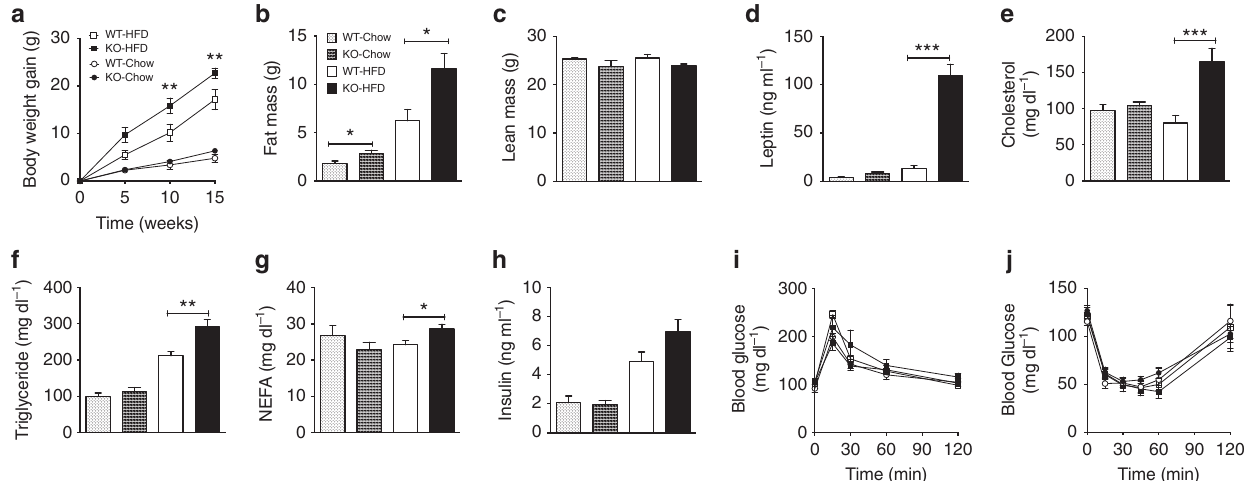
Figure 2 | HDAC5 knock-out mice are prone to diet-induced obesity. Male HDAC5 WT and KO littermates were subjected to either chow or HFD and evaluated for ( a ) body weight gain over a total of 15 weeks; ( b ) fat and ( c ) lean mass after 8 weeks of chow or HFD exposure ( n ¼ 6–8). After 10 weeks of HFD and 15 weeks of chow exposure, plasma ( d ) leptin, ( e ) cholesterol, ( f ) triglyceride, ( g ) non-esterified fatty acid and ( h ) insulin levels were measured in additional cohorts of chow- or HFD-fed HDAC5 WT ( n ¼ 6–7) and KO mice ( n ¼ 9–10). ( i ) Glucose tolerance and ( j ) insulin tolerance tests were carried out after 8 weeks of diet exposure ( n ¼ 4–8). Values represent means ± s.e.m. Statistical analyses were done by either two-way ANOVA with Bonferroni post hoc tests ( a , i , j ), or two-tailed unpaired Student’s t -test ( b – h ). * P o 0.05, ** P o 0.01 and *** P o 0.001. NATURE COMMUNICATIONS|7:10782|DOI: